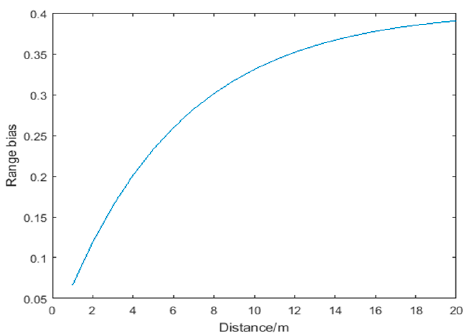
Figure 4. Ranging error when distance d is within 20 m.